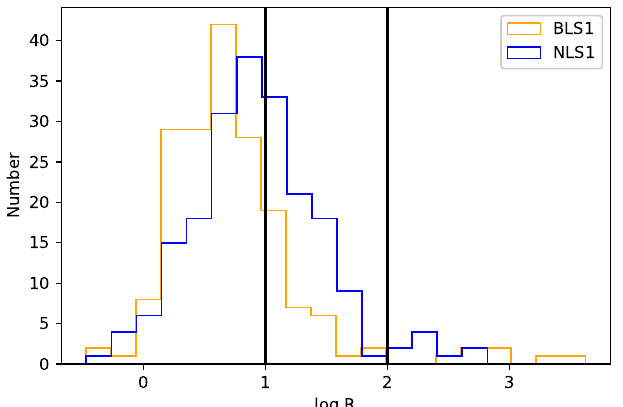
Figure 4. The distribution of radio loudness for LoTSS detected NLS1s and BLS1s. The vertical lines show the radio loudness equalling 10 and 100, respectively.